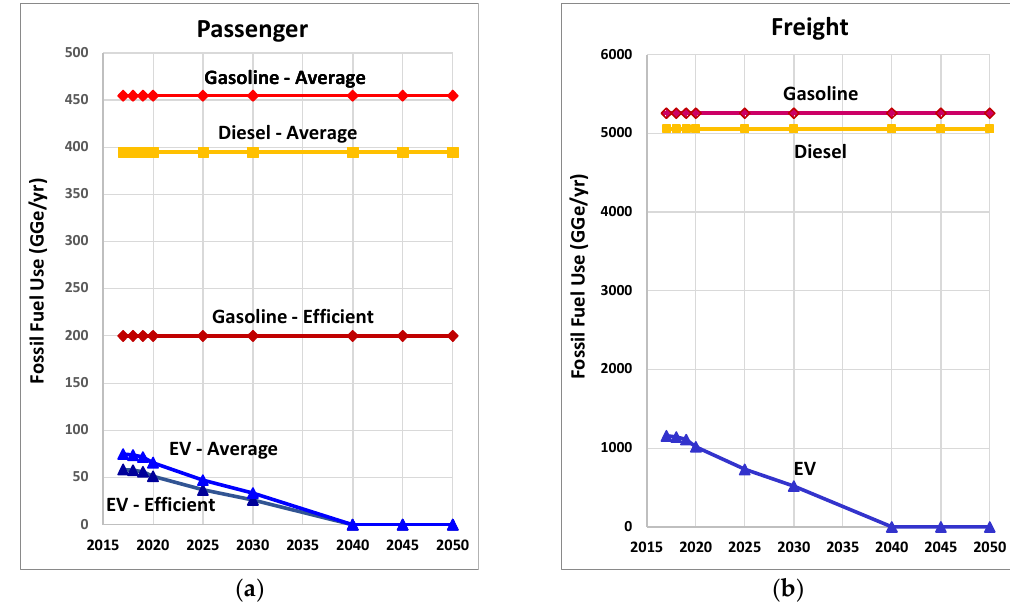
Figure 7. Annual fossil fuel consumption for vehicles on Oahu for 2017 through 2020 and projected out to 2050 under the faster renewable power projection: ( a ) Passenger; ( b ) Freight.